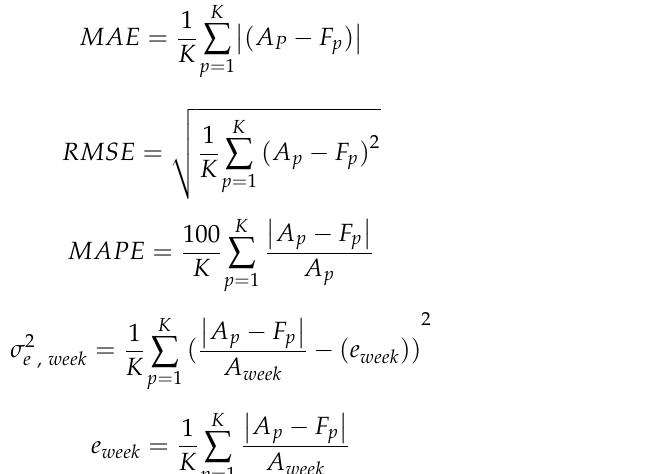
Table 3 indicates the season-wise importance of different features. From the Table 3